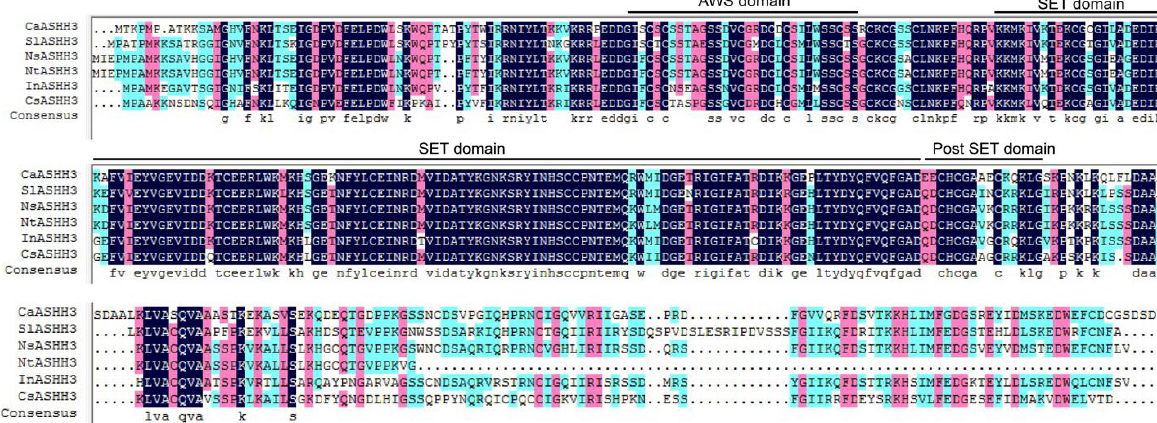
Figure 1 . Multiple sequence alignment of sequences of proteins related to CaASHH3 . Comparison of deduced amino acid sequence of CaASHH3 with related proteins of Solanum lycopersicum SlASHH3 (XP004228631.1), Nicotiana sylvestris NsASHH3 (XP009773063.1), Nicotiana tabacum NtASHH3 (XP016443214.1), Ipomoea nil InASHH3 (XP019152077.1), and Citrus sinensis CsASHH3 (XP006478510.1). Green shading indicates 50 – 75% similarity, red shading denotes 75 – 100% similarity, and black shading represents 100% similarity. Alignment was carried out by DNAMAN5.